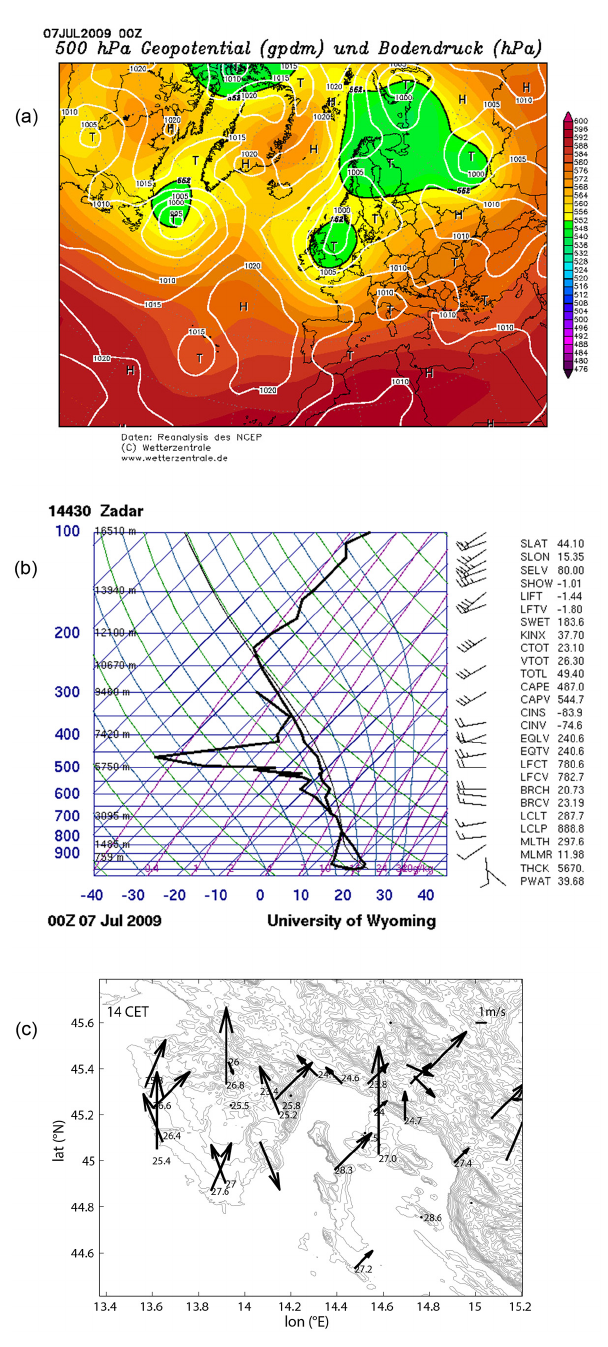
Fig. 10. Case C4, 7 July 2009: (a) surface and 500hPa pressure distribution at 00:00UTC (i.e. 01:00CET); (b) radio sounding pro- files plotted on a skew T-log p diagram in combination with con- vective indices in Zadar (44.10 ◦ N, 15.35 ◦ E) station at 00:00UTC (i.e. 01:00CET); (c) measured 10m wind vectors (ms − 1 ) and 2m air temperatures ( ◦ C) at 14:00CET (measuring sites in Fig. 1a).